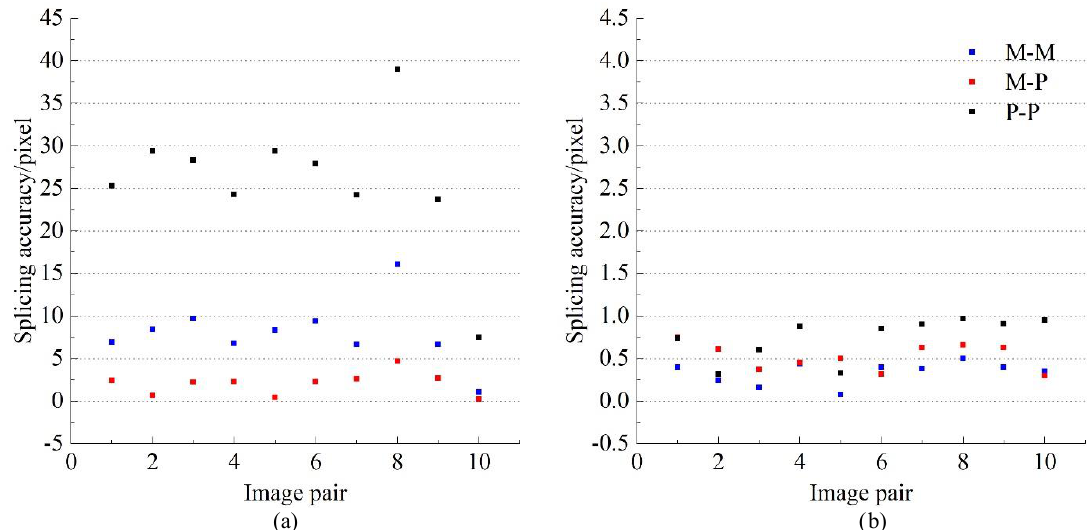
Figure 3. Relative geometric accuracy of adjacent image pairs. (a) before BA; (b) after BA. For an intuitive comparison of the improvement in relative between panchromatic images (Figure. 4(c)), before and after geometric accuracy, we performed a vision comparison of BA. As shown in Figure. 4, in which improvement of the relative splicing between multispectral images (Figure. 4(a)), between geometric accuracy is apparent. multispectral and panchromatic images (Figure. 4(b)), and